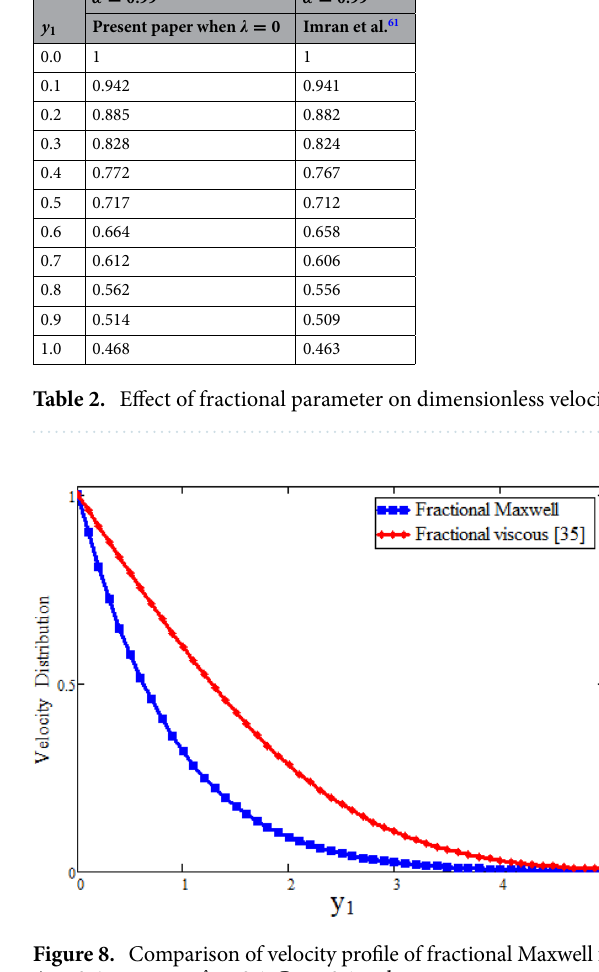
Figure 8. Comparison of velocity profile of fractional Maxwell fluid with viscous fluid 59 , when: t = 1.5 , φ = 0.4 , Pr = 6.2 , (cid:31) = 0.1 , Gr = 0.1 and α = 0.8.